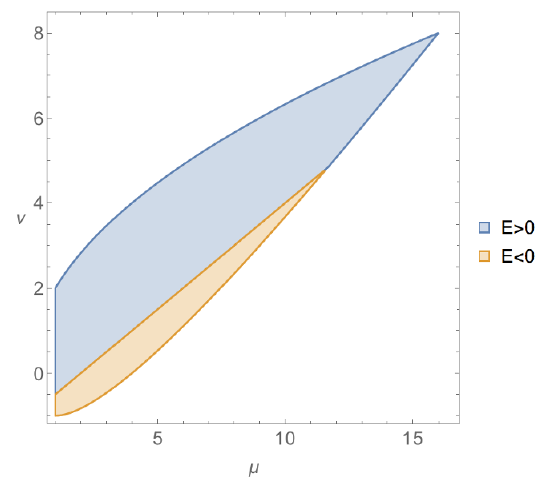
Figure 11 . Moduli space of region D4 where the energy can become